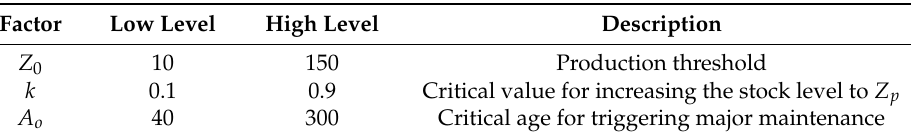
Table 3. Cost parameters for the statistical analysis.